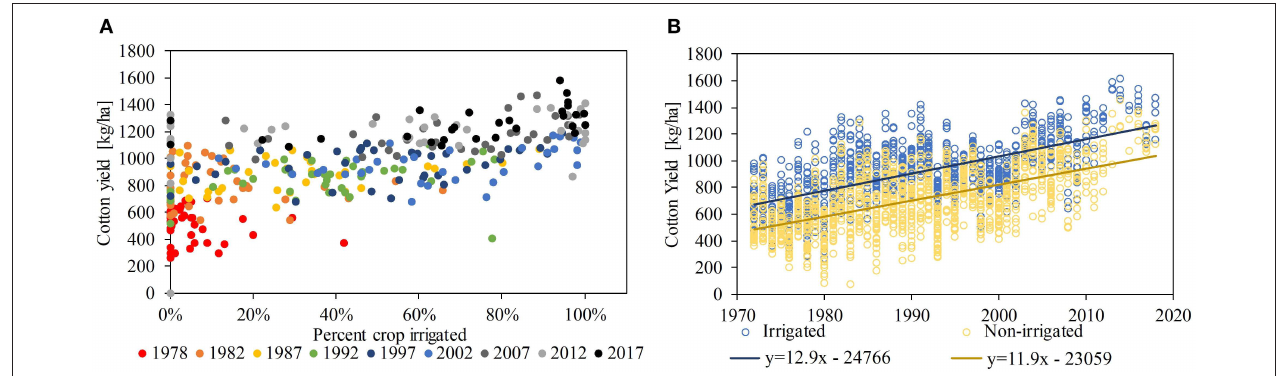
FIGURE 4 | County/Parish cotton yield trends: (A) cotton yield vs. percent crop irrigated from the Census of Agriculture, different years are represented by different color dots; (B) cotton yield vs. time for irrigated (blue) and non-irrigated (yellow) cropland from the survey dataset, the linear trend lines for each dataset are also shown.